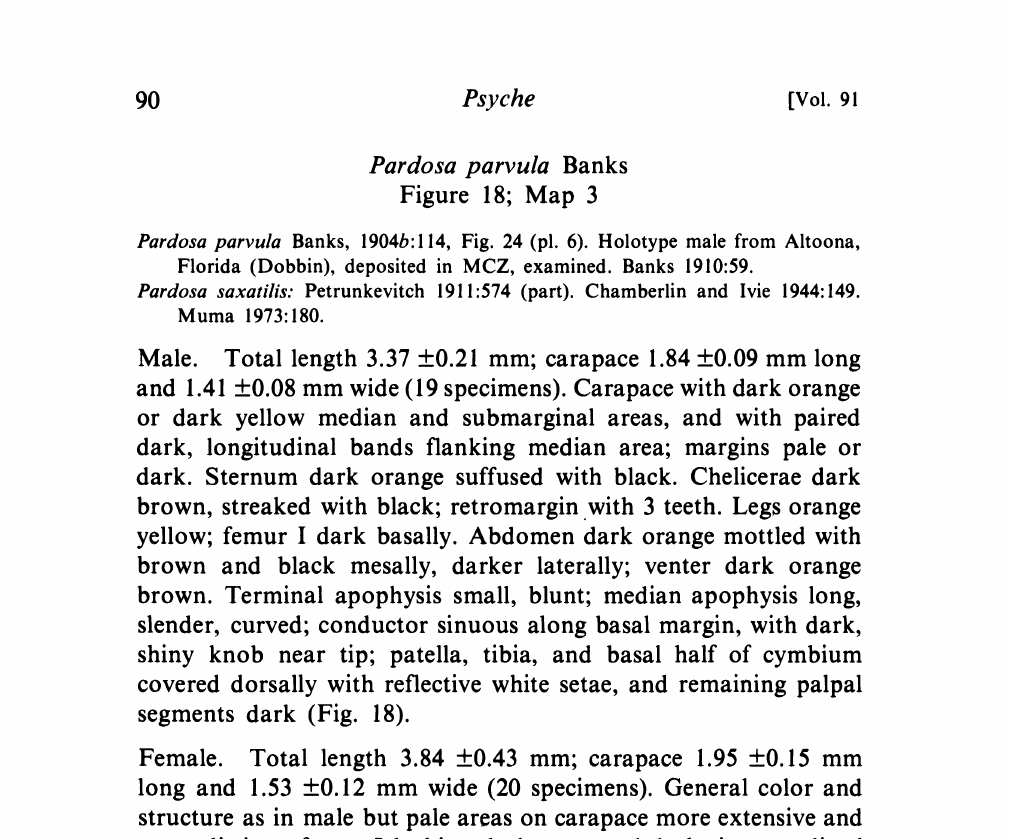
Figure 18; Map 3 Pardosa parvula Banks, 1904b:114, Fig. 24 (pl. 6). Holotype male from Altoona, Florida (Dobbin), deposited in MCZ, examined. Banks